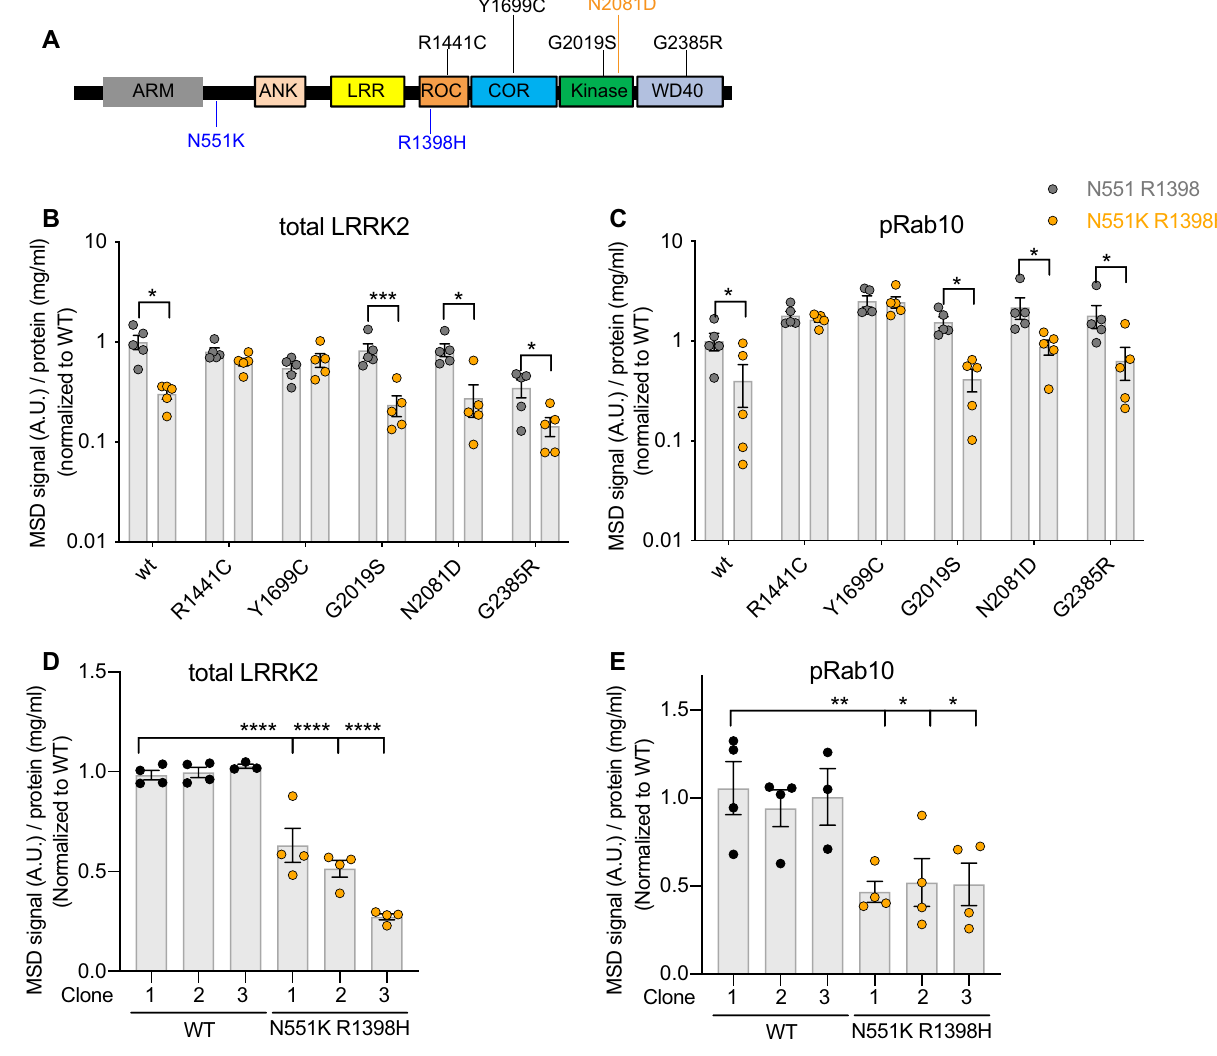
Figure 6. The LRRK2 protective variant reduces LRRK2 levels and activity in cellular models. ( A ) Schematic overview of LRRK2 risk and protective variants associated with PD and Crohn’s disease (CD). N551K R1398H: protective variant associated with both PD and CD (in blue). N2081D: a risk variant associated with CD (in orange). ( B , C ) In HEK293T cells overexpressing different LRRK2 variants and Rab10, total LRRK2 and pT73 Rab10 levels were reduced with the LRRK2 N551K R1398H variant on its own or with PD-linked LRRK2 variants in the kinase and WD40 domains; n = 5–6. Data were normalized for protein concentration and then normalized to the median within the batch and to the wildtype group; shown as mean ± SEM with p values based on paired t-tests on log transformed data, without adjustment for multiple comparisons. ( D , E ) LRRK2 and pT73 Rab10 levels were reduced in LRRK2 N551K R1398H KI A549 cells. Three wildtype pooled cells and three clones of LRRK2 N551K R1398H KI A549 cells were used; n = 4 experiments. Data are displayed as MSD signals normalized for protein concentration and then normalized to the median within the batch and to the wildtype group and are shown as mean ± SEM with p values: one-way ANOVA with Sidak’s multiple